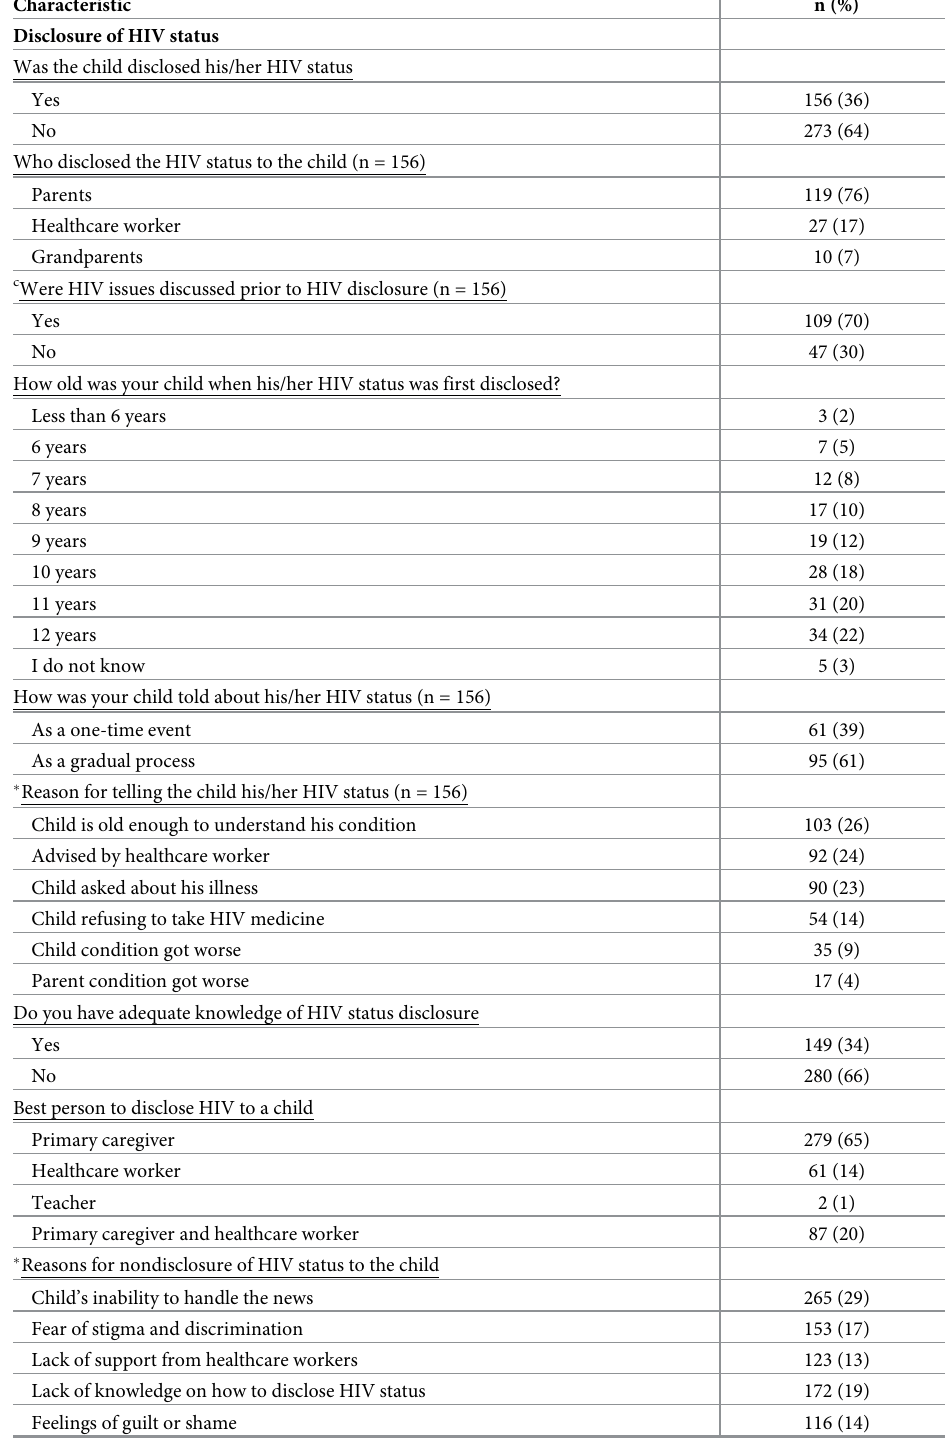
Table 3. Prevalence of primary caregiver knowledge and practice of HIV disclosure (N = 429).